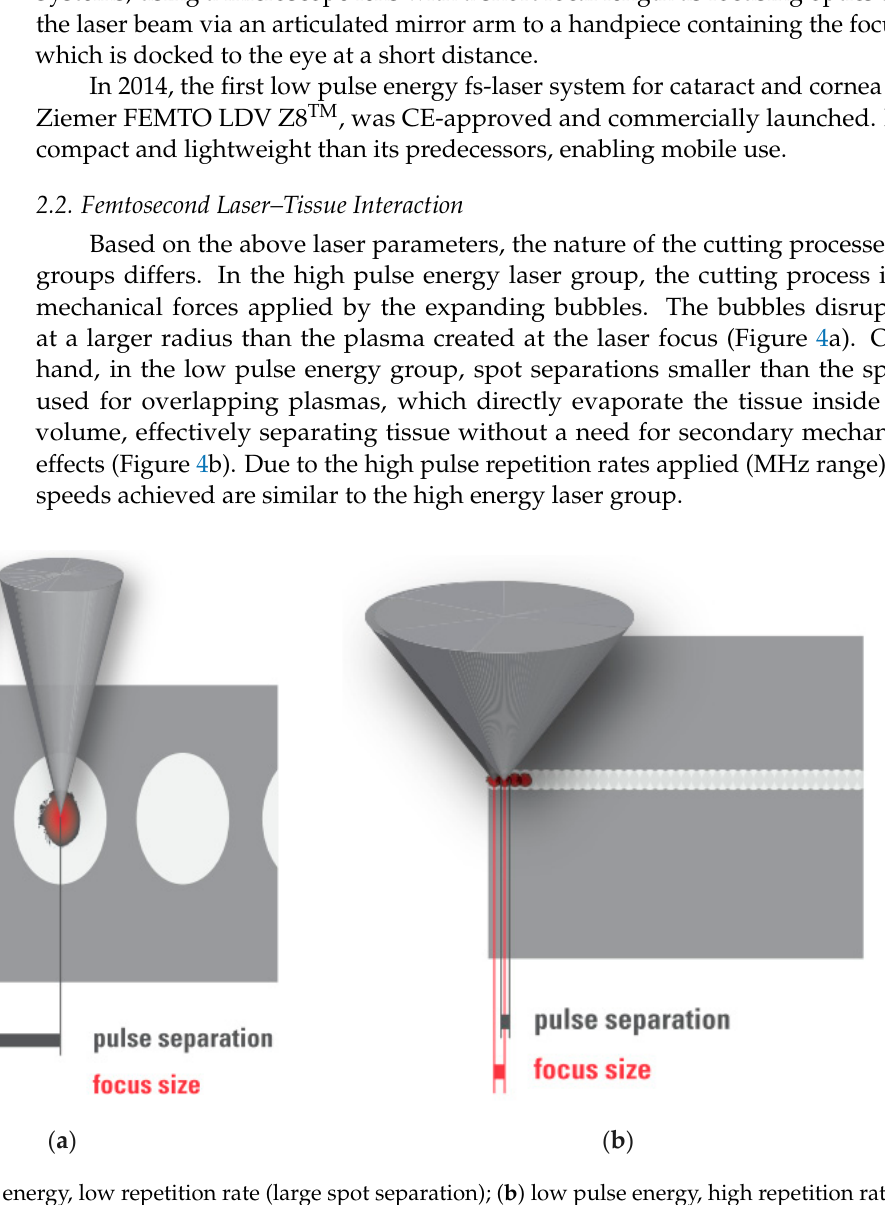
Figure 3. The focal volume of a Gaussian laser beam scales with the numerical aperture NA = w/f of the focusing lens. The larger the NA, the smaller the focal spot volume.